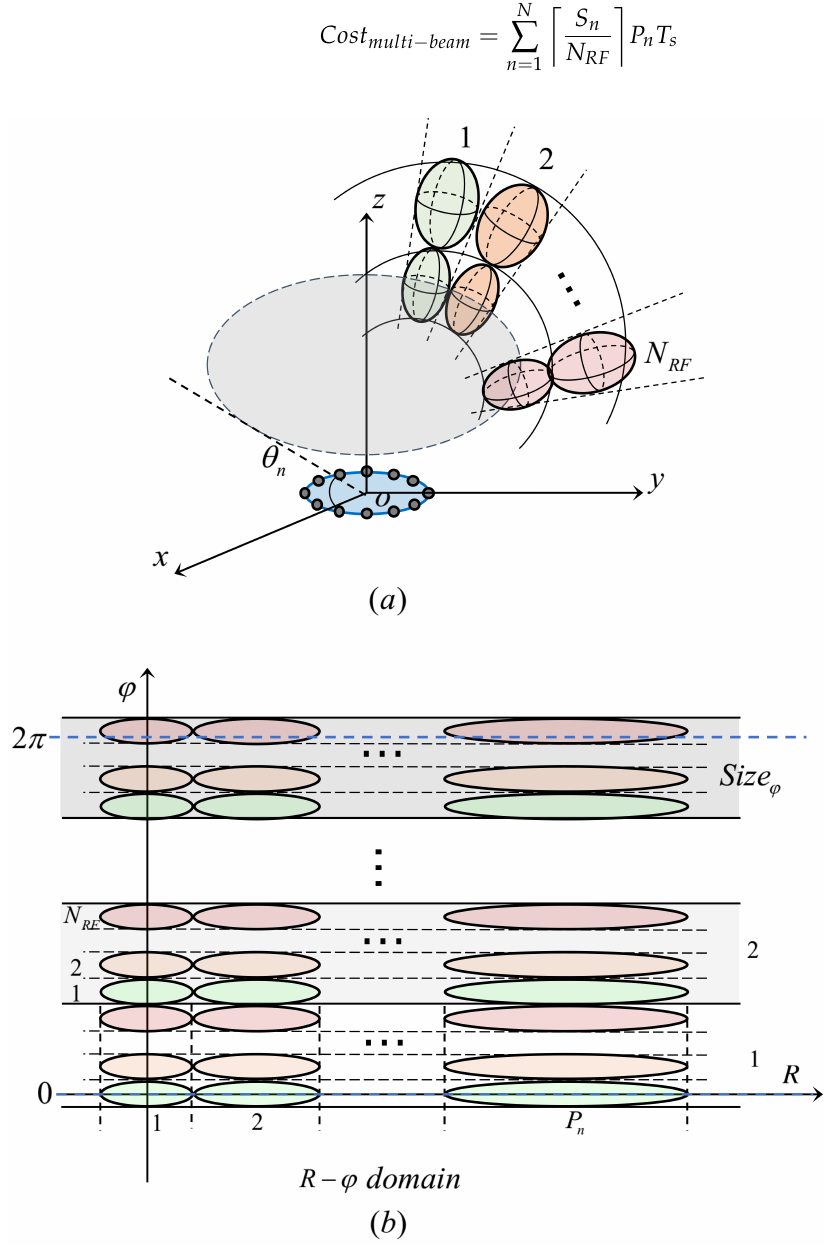
Figure 8. Illustration of multi-beam training scheme ( a ) in 3D view. ( b ) in R − ϕ domain